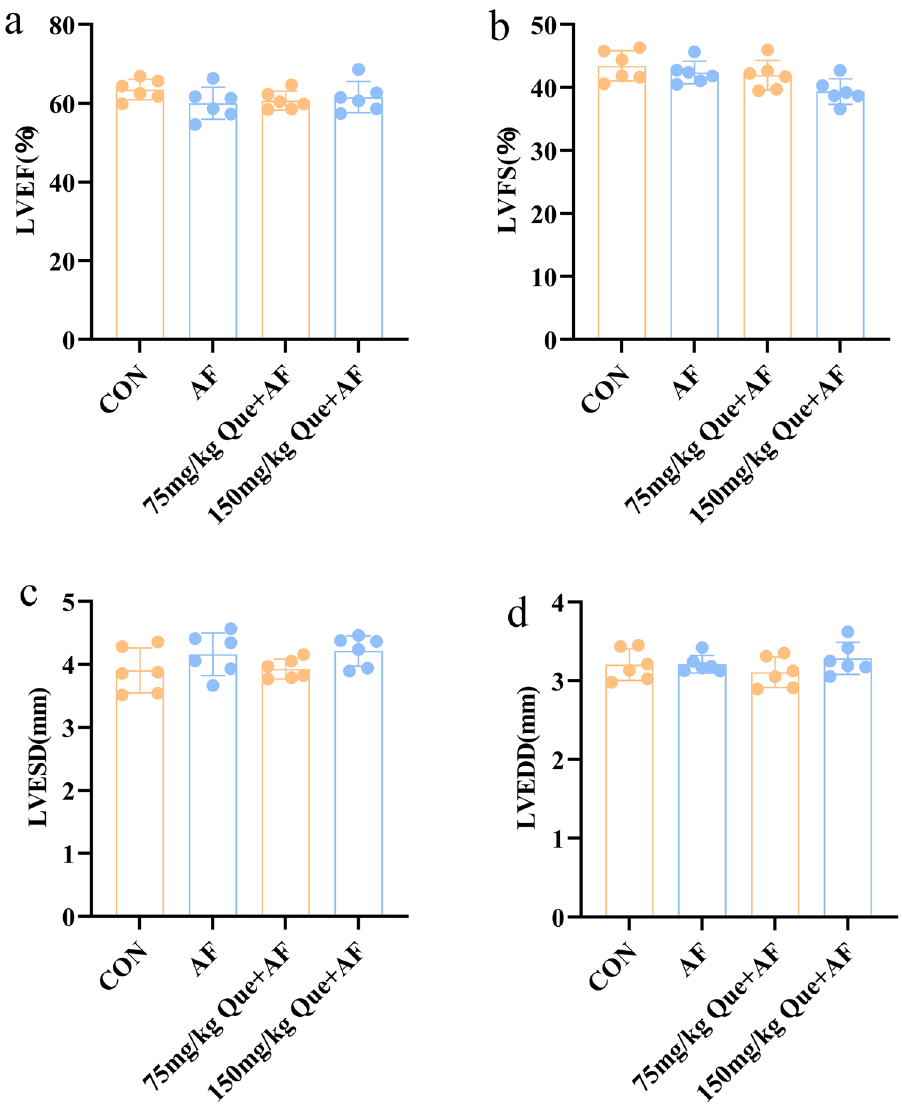
Figure 9. Que had no significant effect on LV function in each group (n = 6). ( a ) LVEF: left ventricular ejection fraction. ( b ) LVFS: left ventricular shortening fraction. ( c ) LVESD: left ventricular end-systolic diameter. ( d ) LVEDD: left ventricular end-diastolic ductal